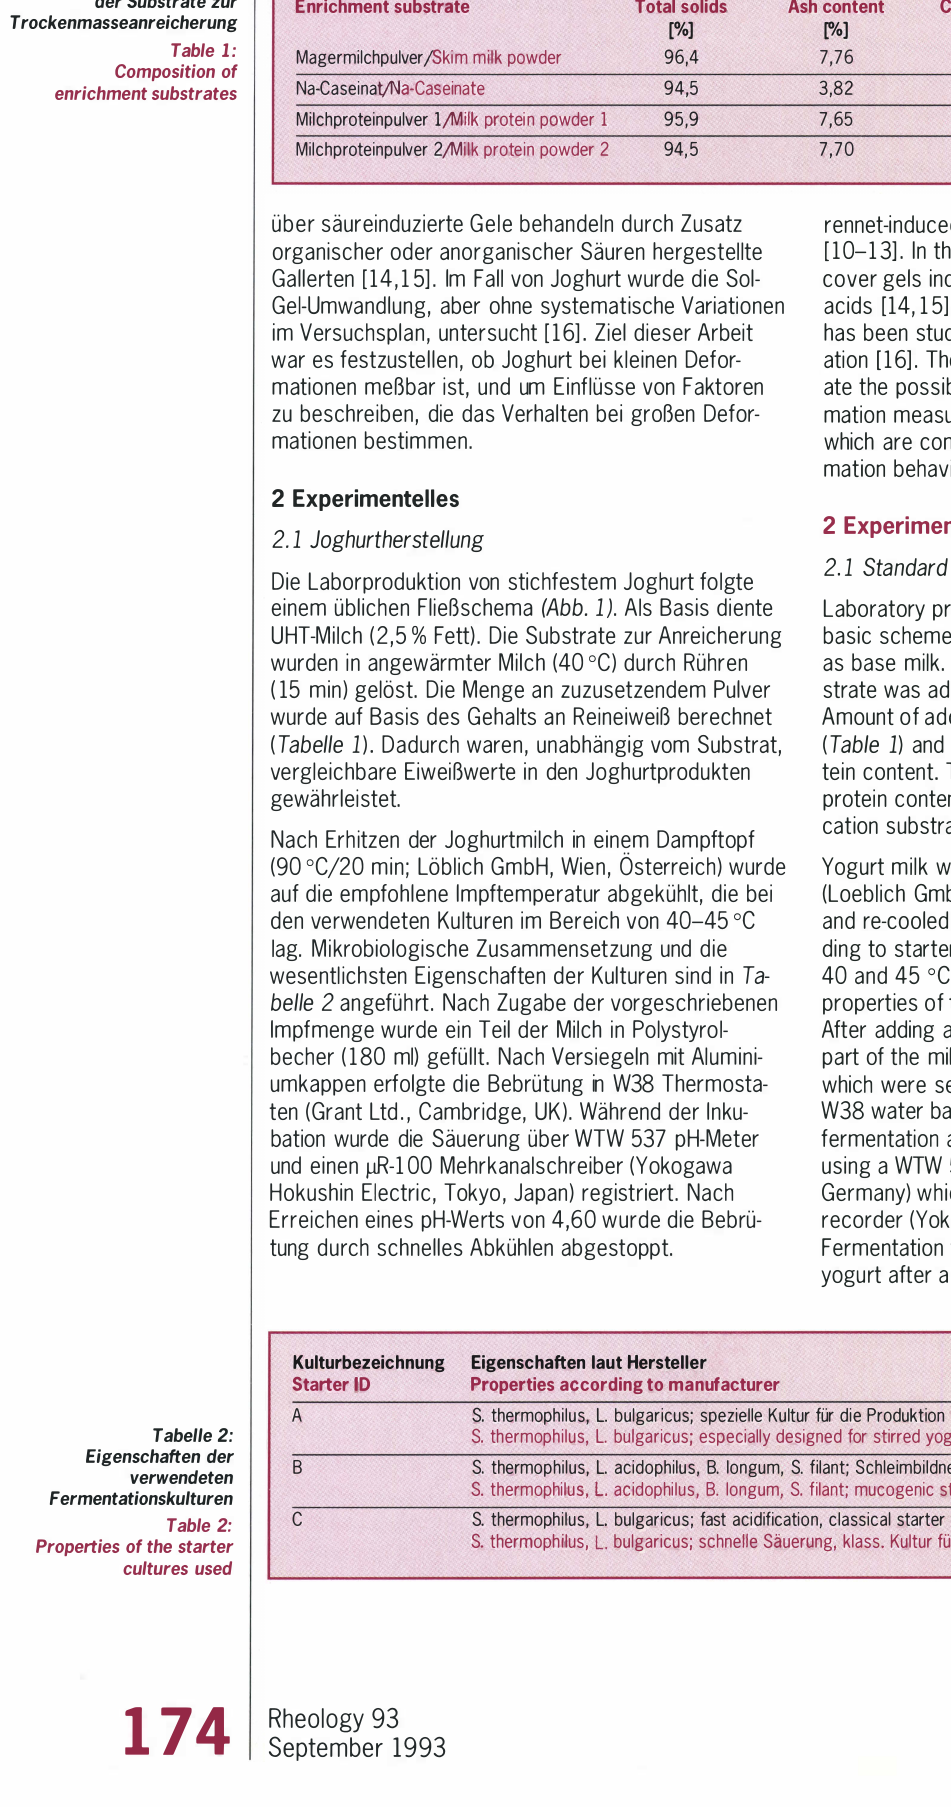
Tabel/e 1: Zusammensetzung der Substrate zur Trockenmasseanreicherung Table 1: Composition of enrichment substrates